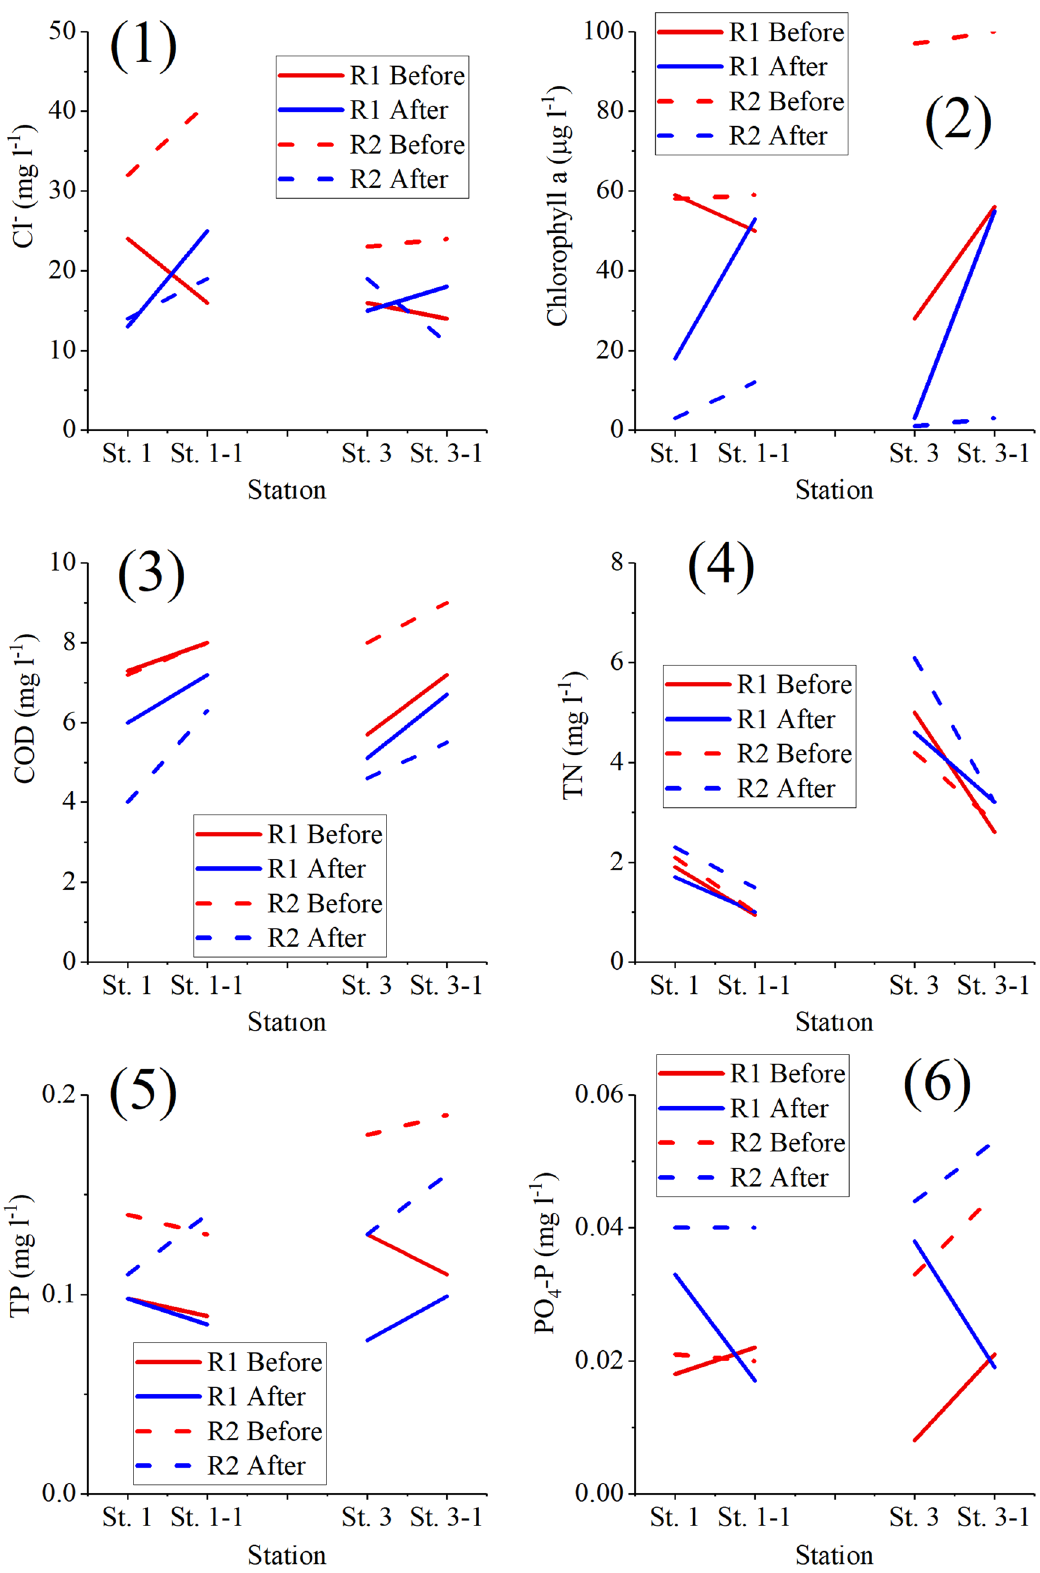
the latter monitoring day: 201 mm for St. M1, 178 mm for St. M3). For R2, before: Sep 25, 2019, after: Oct 31, 2019 (179 mm, 258 mm,